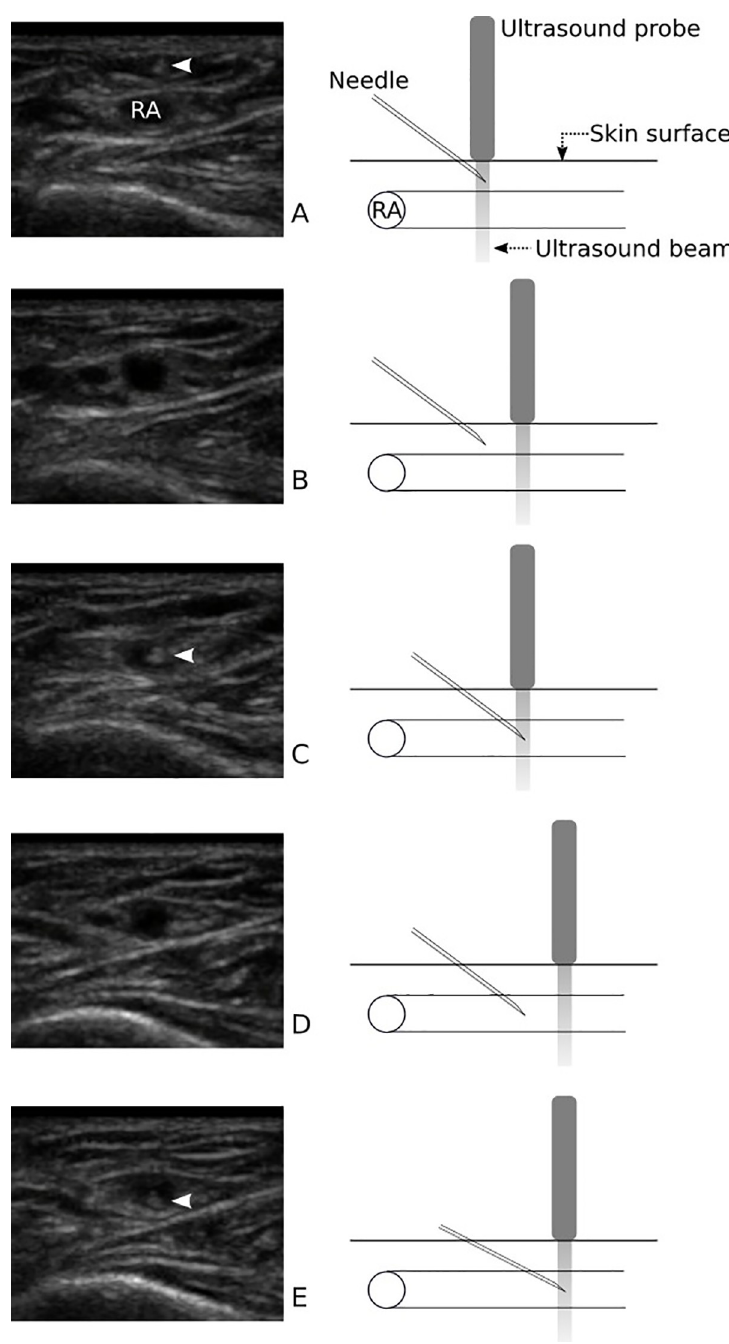
Fig 2. Ultrasound-guided DNTP technique. The radial artery (RA) was identified in an out-of-plane approach with an ultrasound probe. (A) The needle was inserted through the skin, and the needle tip ( arrowhead ) appeared as a hyperechoic dot on the display. (B) The probe was moved slightly further without moving the needle, and the hyperechoic dot disappeared as the needle tip exited the ultrasound plane. (C) The needle was advanced toward the radial artery with the probe held in place, and the needle punctured the radial artery. (D) The probe was moved proximally again, and the needle tip disappeared from the display. (E) The needle was advanced, and it was confirmed that the needle tip remained in the radial artery. Arrowheads on the ultrasound images indicate the needle tip of the angiocatheter. DNTP, dynamic needle tip positioning.